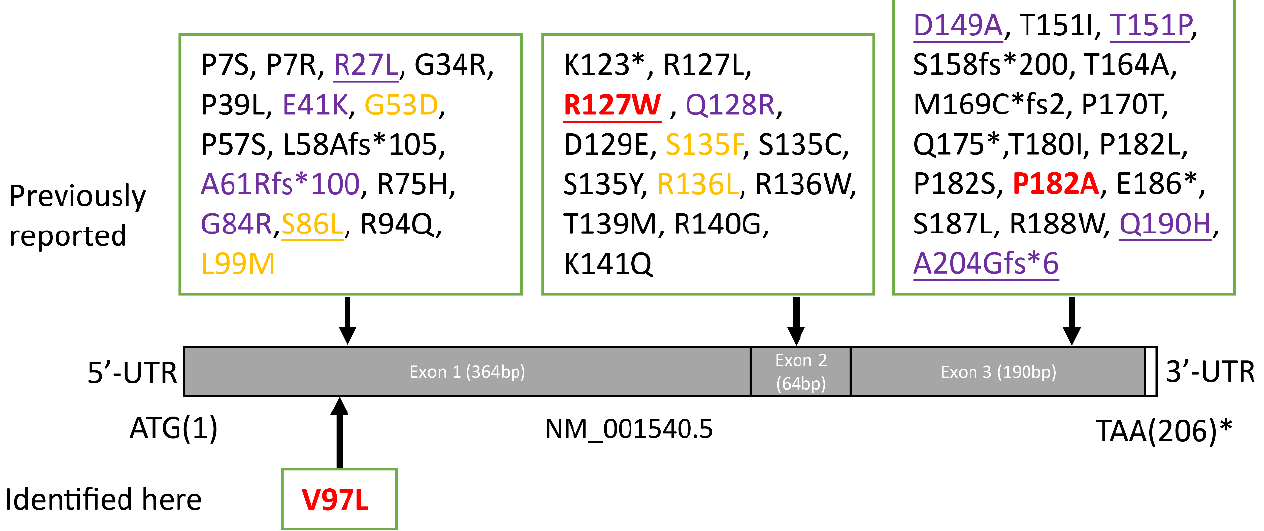
Figure 5. The schematic diagram of HSPB1 structure with mutations. Full length of HSPB1 (NM_001540.5) in brown consists of 205 amino acids. * stop codons; red, reported here; yellow, AR inheritance; purple, UMN involvement; underline, ALS-like phenotype.